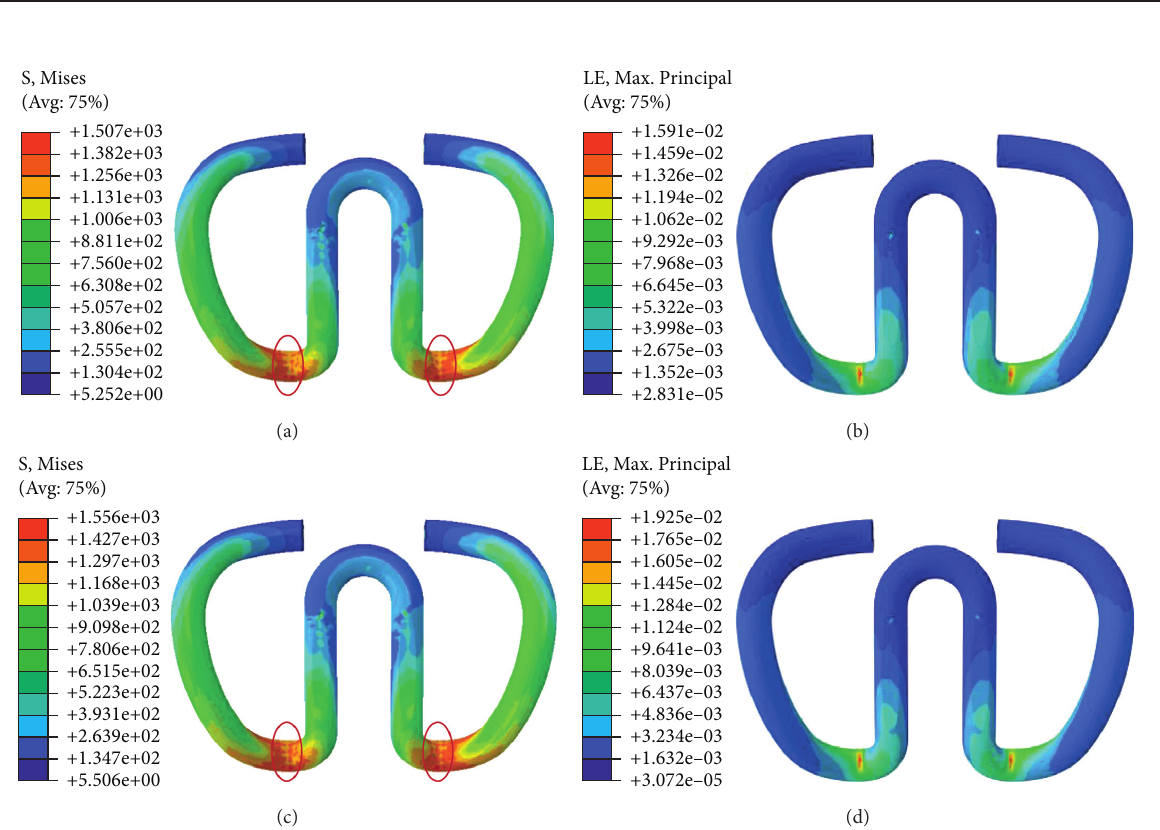
Figure 10: Stress/strain distributions of the fastening clip in FEA: (a) von Mises stress distribution for case 1; (b) maximum principal strain